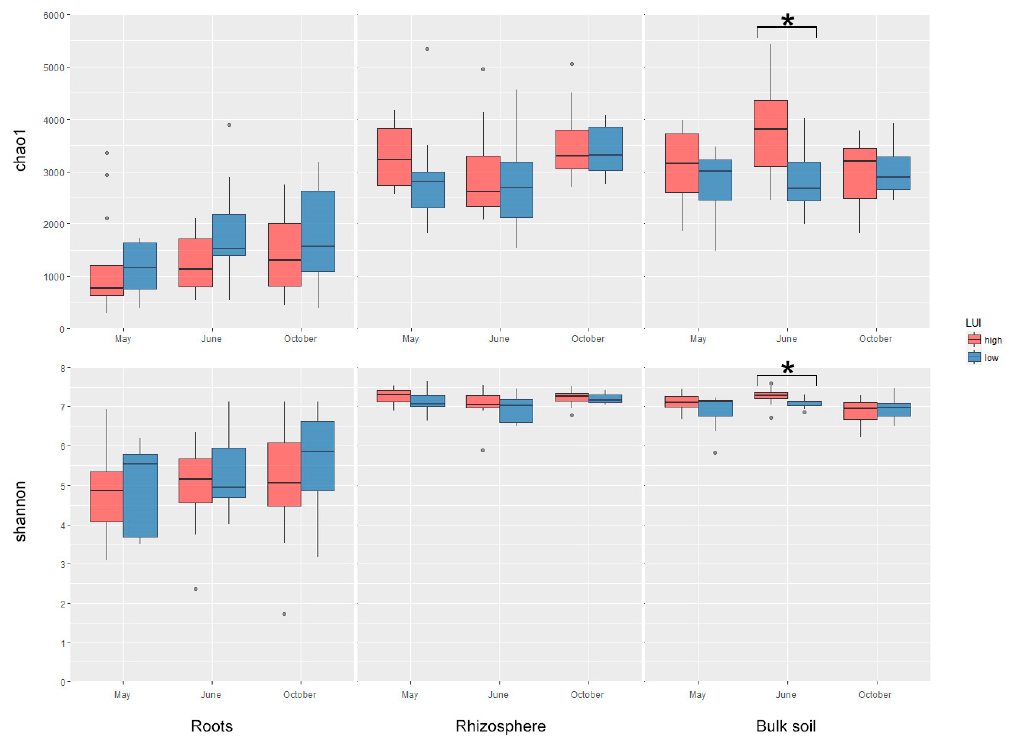
Figure 1. α -diversity measures chao1 species richness and Shannon index of all compartments under low and high land use intensity, respectively. The distribution is shown at 97% sequence similarity. The boxplot indicates the first and third quartile. The median is indicated as a horizontal line and whiskers indicate minimum or maximum, respectively. Significant differences among land use intensities are indicated with an asterisk, circles reflect outlier values ( t -test, p < 0.05). Beta-diversity was also impacted by LUI to a large extent, mainly in June, when e ff ects of LUI on all compartments were observed. In addition, significant di ff erences between di ff erent LUI